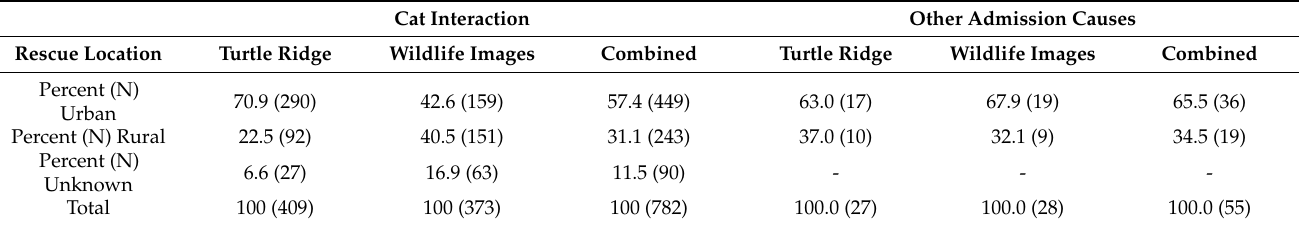
Table 5. Percentage of bird admissions coming from urban or rural locations. Records involving interaction with a cat do not add up to 100%, as some records from this category had incomplete location information. Records from other causes of admission were not included in analysis of location information if this information was